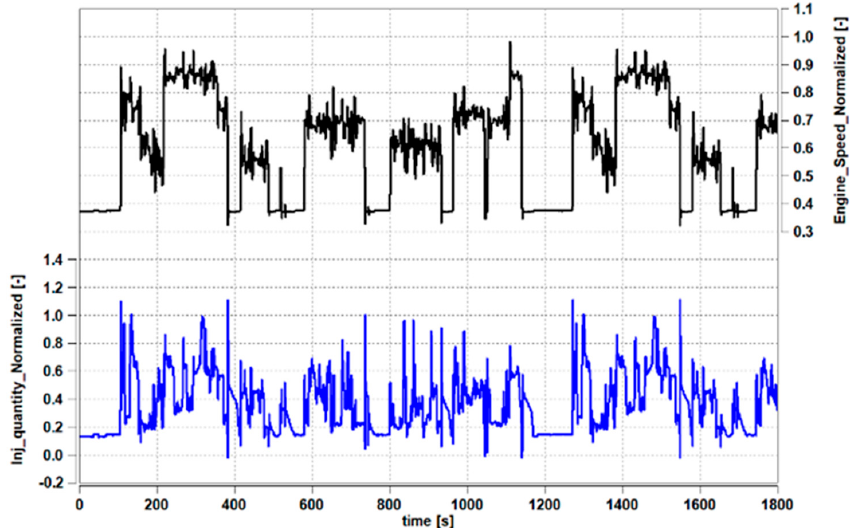
Figure 26. Top: engine speed (normalized with respect to the maximum value reached in the test) of vehicle duty cycle; Bottom: injected quantity of vehicle duty cycle (normalized with respect to the maximum value reached in the test).